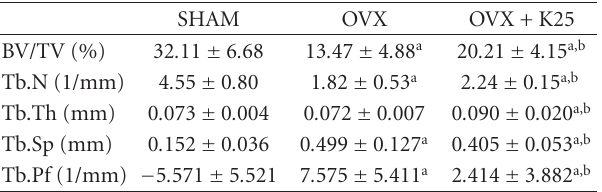
Table 2: Bone Area (BA), bone mineral content (BMC), and bone Table 3: 3D trabecular microarchitecture analysis of femur by mineral density (BMD) measured in femur and in lumbar vertebra microtomography in rats which were sham operated (SHAM), in female Wistar rats at the end of the study. Six-month-old rats ovariectomized (OVX), or ovariectomized and treated with kalsis at the beginning of the study, ovariectomized (OVX) or sham- (OVX + K25). The parameters studied are bone volume/total operated (SHAM) were randomized in the following groups: SHAM volume (BV/TV; %), trabecular number (Tb.N; 1/mm), trabecular group (SHAM), treated with vehicle for 3 months; ovariectomized thickness (Tb.Th; mm), trabecular separation (Tb.Sp; mm), and group (OVX) also treated with vehicle for 3 months; ovariectomized trabecular pattern factor (Tb.Pf; 1/mm). Female Wistar rats, 6 group treated with Kalsis at a dose of 25 mg/kg/day, for 3 months months old at the beginning of the study, ovariectomized (OVX) (OVX + K25). Statistical significance P < 0 . 05: a versus SHAM; b or sham-operated (SHAM) and randomized in the following versus OVX. groups: SHAM group (SHAM) treated with vehicle for 3 months; ovariectomized group (OVX) also treated with vehicle for 3 months; BA (cm 2 ) BMC (g) BMD (cm 2 /g) ovariectomized group treated with Kalsis at a dose of 25mg/kg/day, Femoral for 3 months (OVX + K25). Statistical significance P < 0 . 05: a vresus SHAM; b versus OVX. SHAM